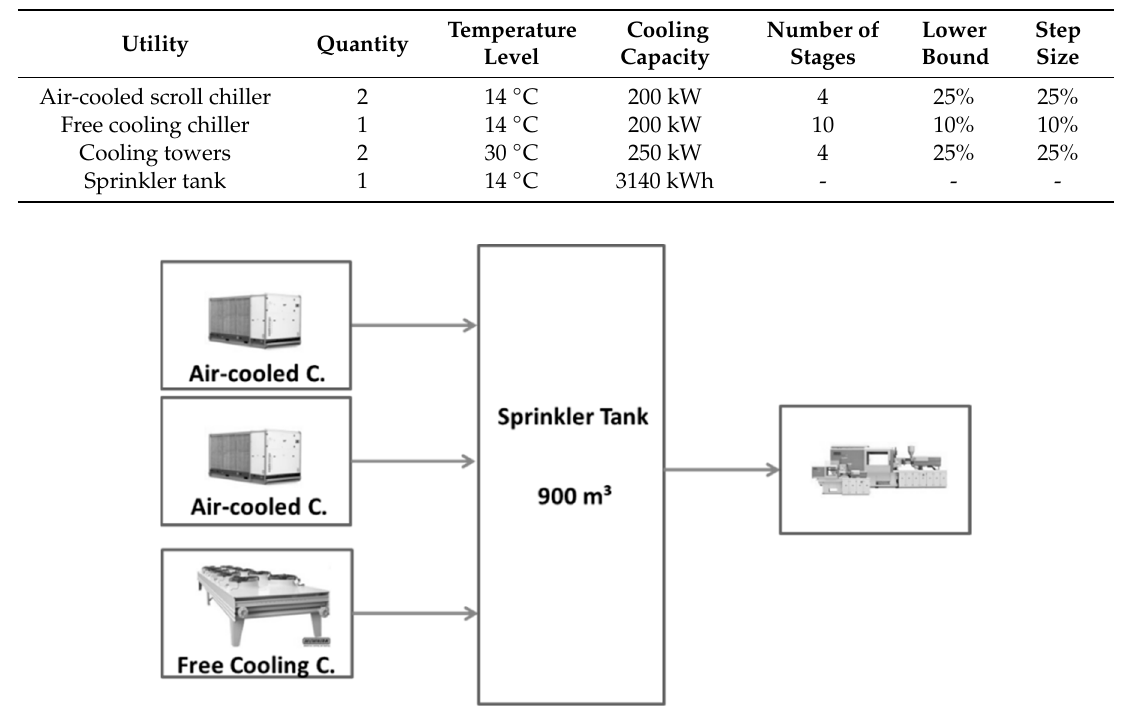
Figure 3. Scheme of cooling system plastic processing company .